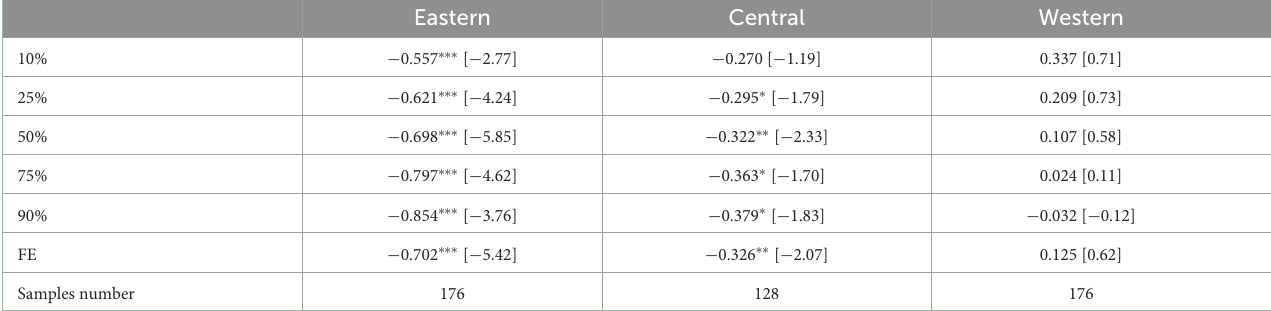
TABLE 3 Regional heterogeneity.